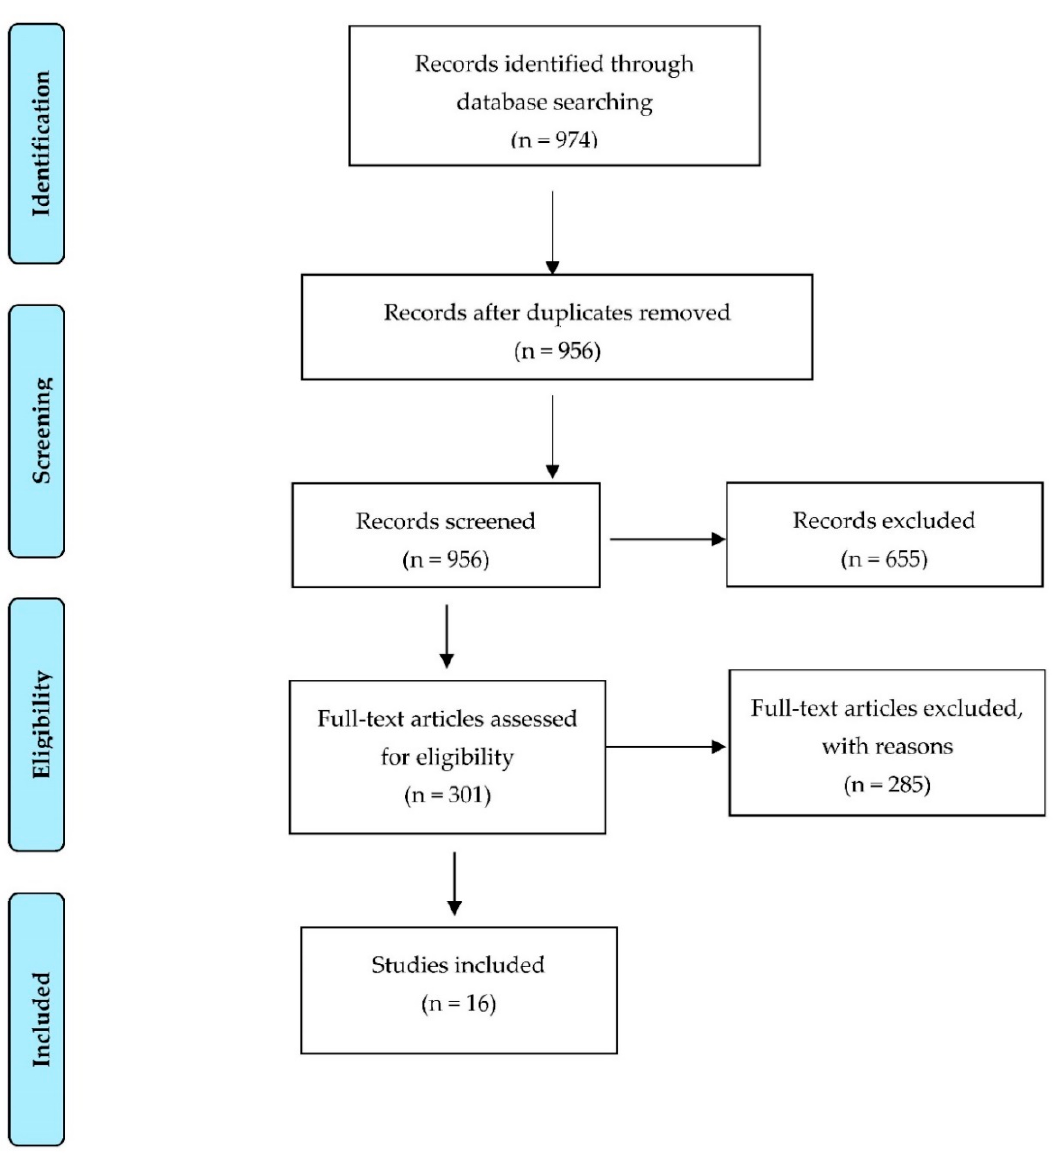
Figure 1. Flowchart for study identification, selection and inclusion. Adapted with permission from: Moher D, Liberati A, Tetzlaff J, Altman D. The PRISMA group Preferred Reporting Items for Systematic Reviews and Meta-Analyses: The PRISMA Statement, 2009 [17].